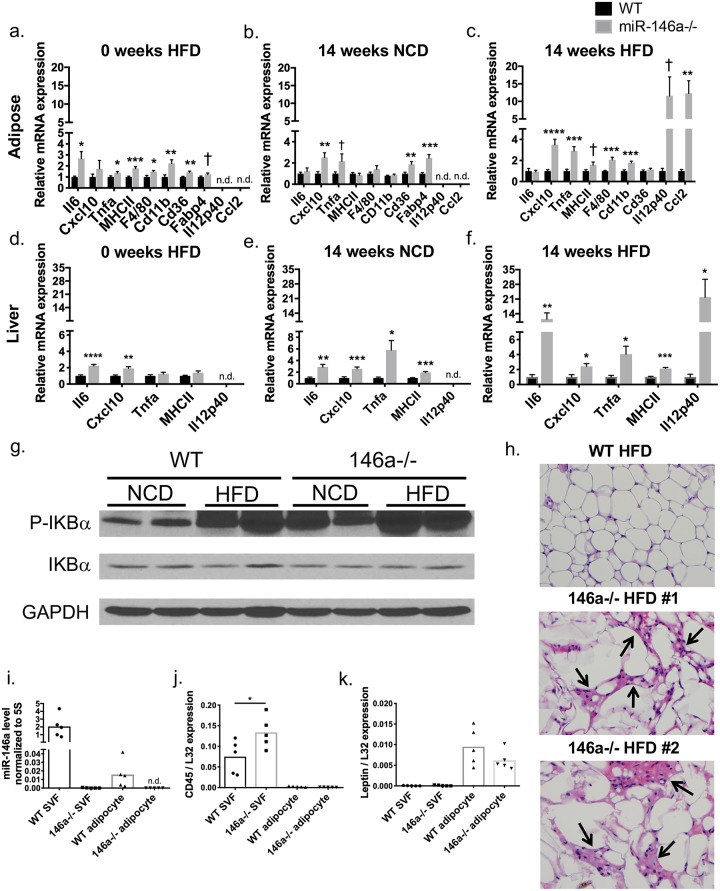
miR-146a constrains inflammation and is expressed in adipose tissue.(A-C) qRT-PCR expression levels of various mRNAs (shown on x axis) measured in WT (black) or miR-146a (grey) mice in whole VAT at (A) 0 weeks HFD; (B) 14 weeks on NCD; and (C) 14 weeks on HFD. (D-F) qRT-PCR expression levels of various mRNAs (shown on x axis) measured in WT or miR-146a mice in liver at (D) 0 weeks HFD; (E) 14 weeks on NCD; and (F) 14 weeks on HFD. (G) Western blot for P-IKBa, total IKBa, and GAPDH in lysates of whole VAT collected from 20-week old WT or miR-146a-/- mice fed NCD or HFD. (H) H&E staining of VAT of WT and miR-146a-/- mice fed HFD for 18 weeks. Black arrows indicate areas of inflammation. Two representative examples from miR-146a-/- VAT are shown, with one representative WT mouse; 400x magnification. (I) Mature miR-146a expression relative to 5s rRNA, measured in the SVF and adipocyte fraction of WT and miR-146a-/- mice fed NCD. (J-K) Ptprc (CD45) and Leptin expression levels, relative to L32, were measured as controls for fractionation purity. Samples were normalized by setting WT expression to 1. Data are shown as mean ± SEM (a-f) (n = 10) or as individual mice (h-k) (n = 5); lysates from individual mice (g) (n = 2). p-value was calculated using two-tailed Student’s t-test. *p<0.05; **p<0.01; ***p<0.001; ns = not significant. See also S4 Fig.